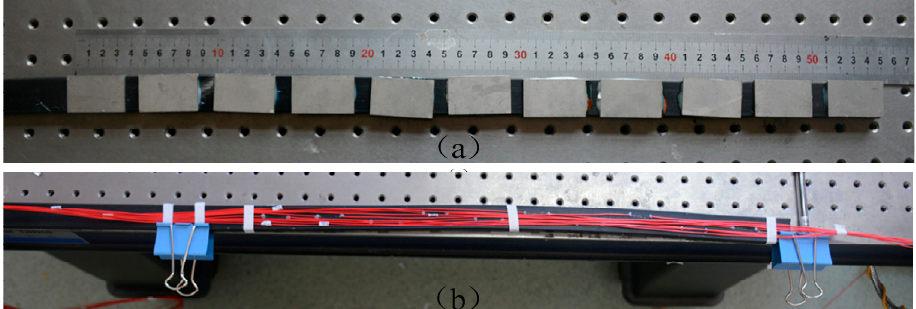
Figure 7. The FBG strain sensor and its measuring principle.